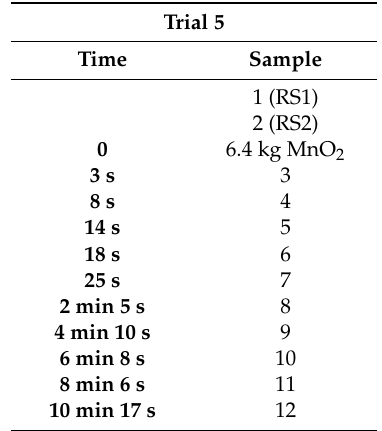
Table 5. The time when each sample was taken after the addition of the tracer and the sample number for Trial